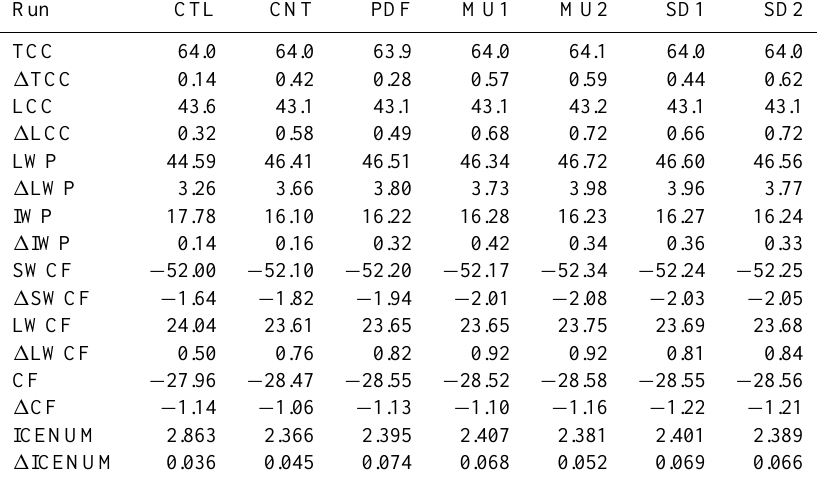
Table 4. Global annual mean fields for the present-day simulations and differences in these variables between present-day and preindustrial simulations. Variables listed in the table are total cloud cover (TCC, %), low cloud cover (LCC, %), liquid-water path (LWP, gm − 2 ), ice water path (IWP, gm − 2 ), shortwave cloud forcing (SWCF, Wm − 2 ), long-wave cloud forcing (LWCF, Wm − 2 ), net cloud forcing (CF, Wm − 2 ) and integrated column ice number concentration in mixed-phase clouds (ICENUM, 10 3 cm − 2